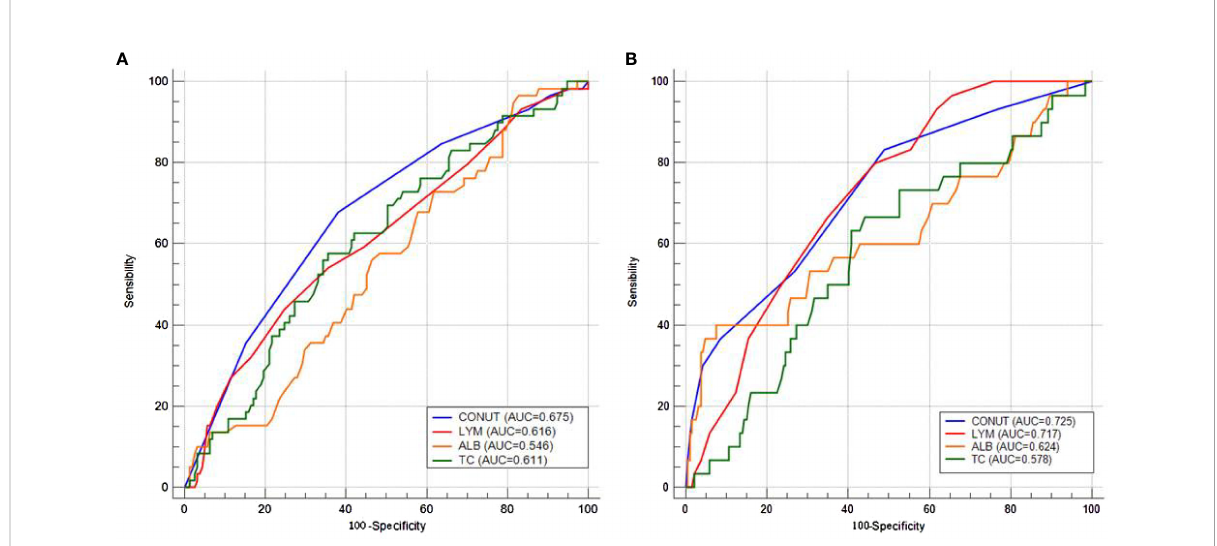
FIGURE 3 Area under the curve comparisons between CONUT and components (lymphocyte, albumin, and total cholesterol) according to the receiver operating characteristic curves in pathologic complete response (A) and recurrence (B) prediction.